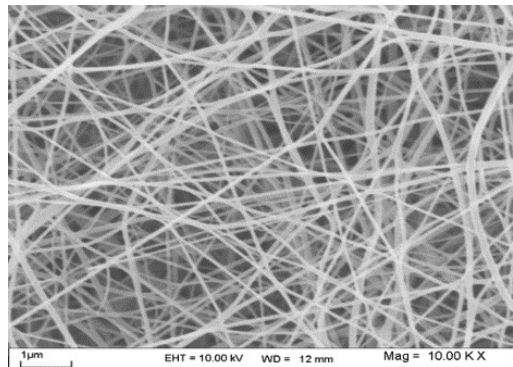
Fig. 1. SEM micrograph of electrospun CS/PEO (90/10) Fig. 1-.SEM micrograph of electrospun CS/PEO (90/10) nanofibrous nanofibrous samples